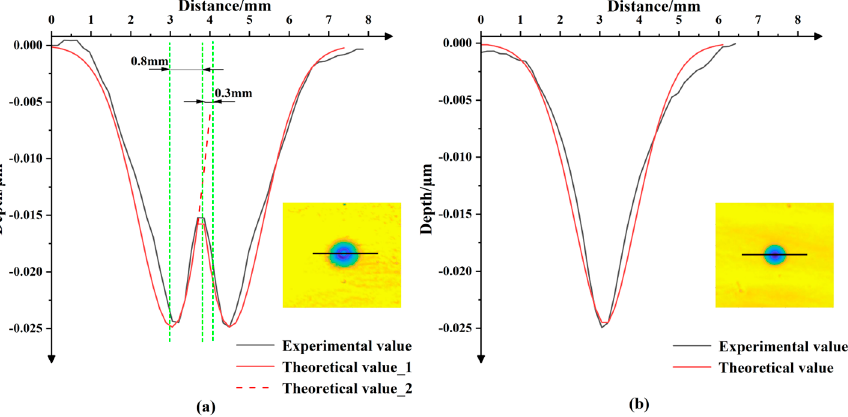
Figure 11. ( a )The experimental TIF curves ( b ) theoretical TIF curves obtained by rotating the nozzle around different rotation centers.